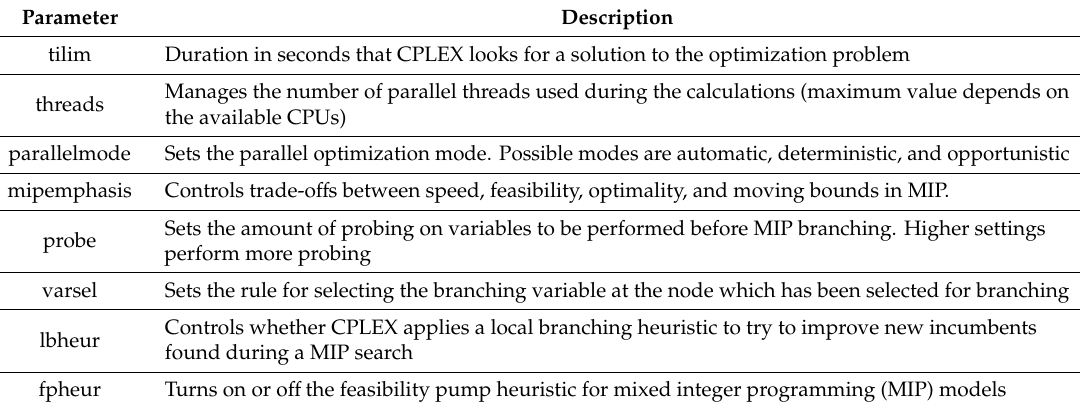
Table 1. Description of CPLEX software parameters that were considered during the execution of optimization